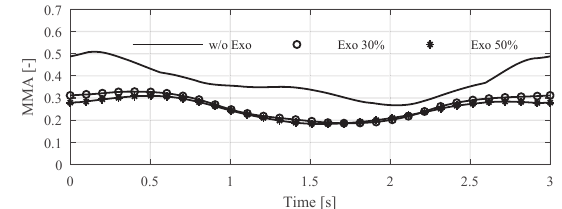
Figure 8: Maximum muscle activity (MMA) in the col- lective muscles of the upper body during bi- cep curl